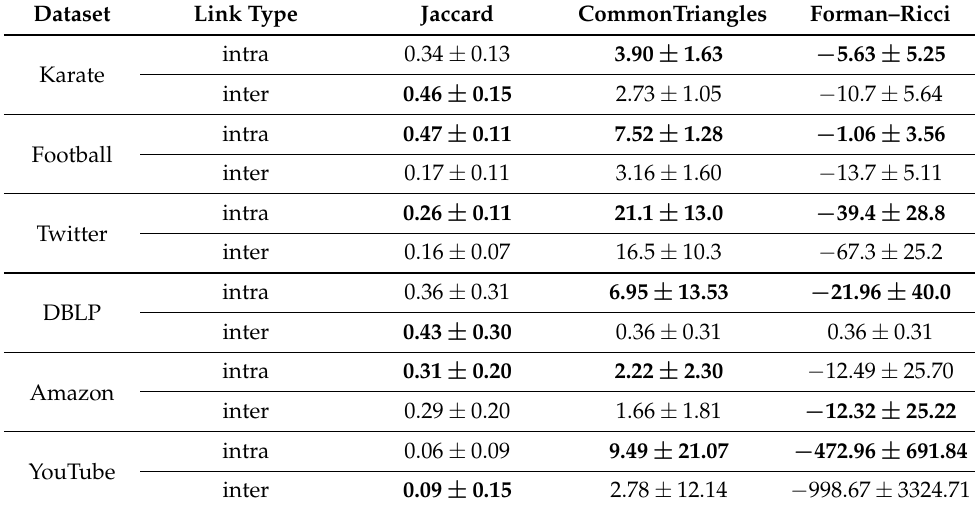
Table 2. Distribution of link attributes in real-world networks.